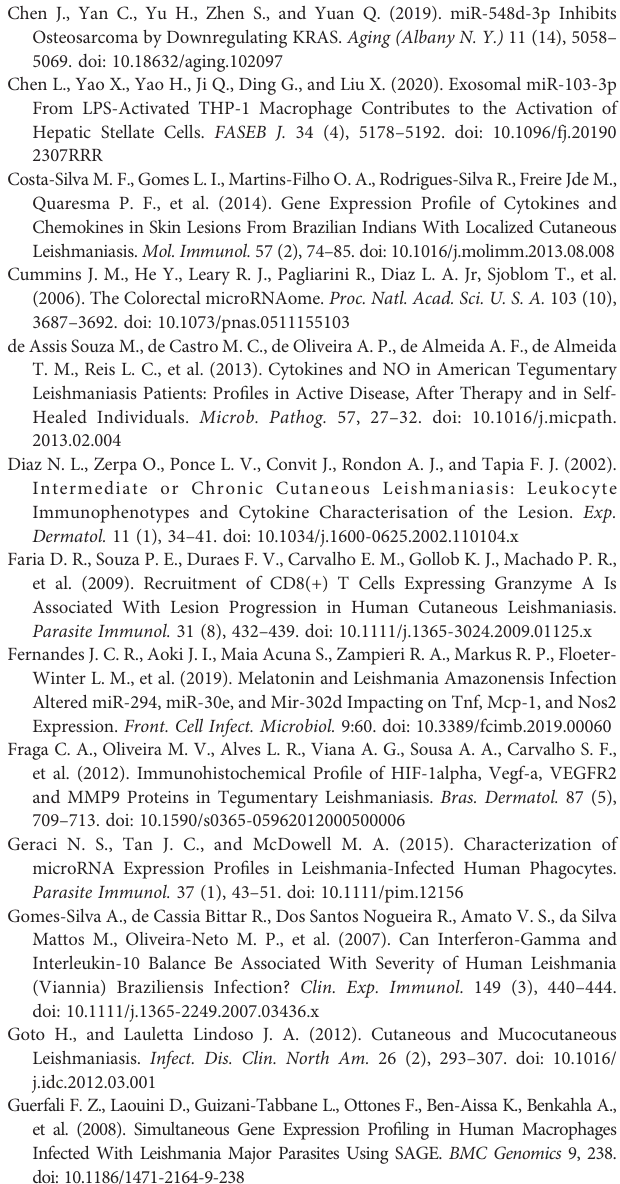
Supplementary Figure 1 | Effect of different concentrations of miR-548d-3p inhibitor or negative control (scrambled miRNA) transiently transfected on parasite load (number of amastigotes/100 cells) in L. (V.) braziliensis promastigote-infected THP-1 cells at 6 h (A) and 24 h (B) post-infection. The experiment was carried out by adding the synthetic molecules at 3nM, 10nM or 30nM with the transfection reagent diluted in RPMI medium or only RPMI medium (non-transfected cells) to wells containing 10 6 THP-1 adherent cells and maintained for 24 h at 37°C (5% CO 2 ) then infected with L. (V.) braziliensis promastigotes. (A) * = P < 0.05 (one way ANOVA and student t test).